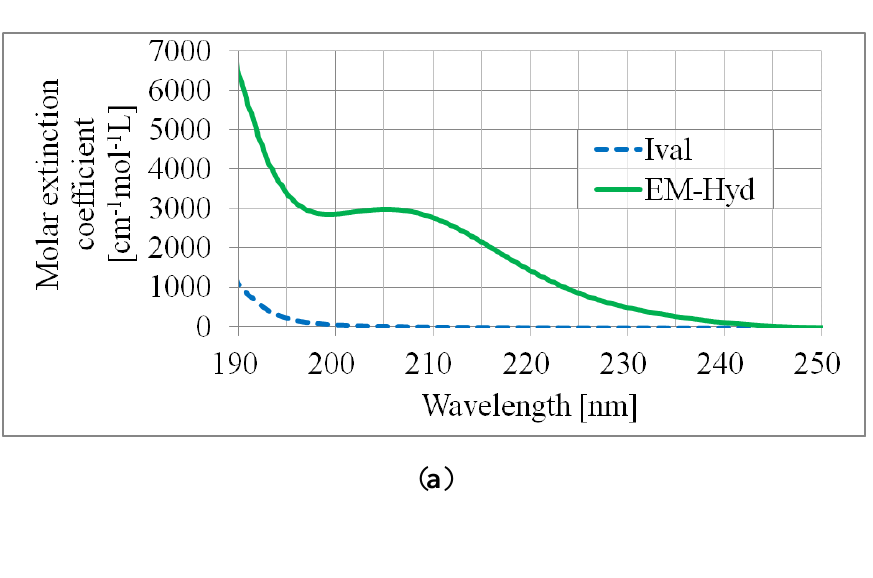
Figure 2. ( a ) UV spectra of Ival and EM-Hyd before irradiation. ( b ) Stability of Ival and EM-Hyd against UV (continuous)